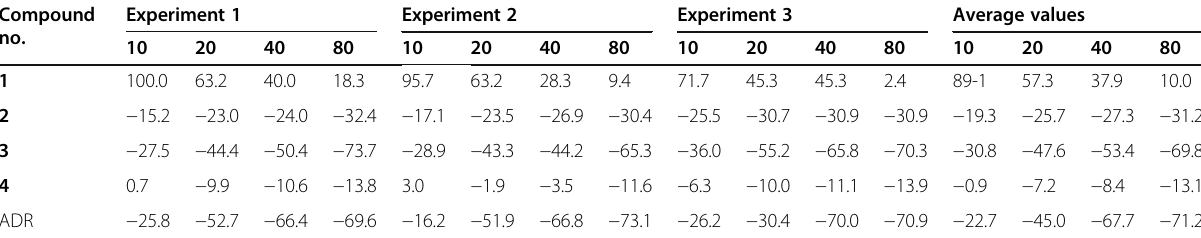
Table 5 % Control growth the drug concentrations ( μ g/mL) BT474 cell line Compound no.